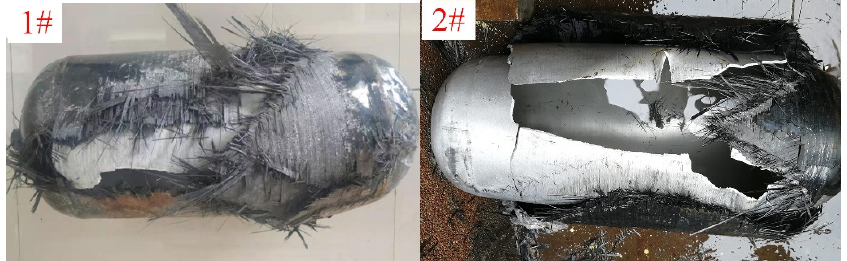
Figure 5. Failure modes of COPVs 1# and 2#.